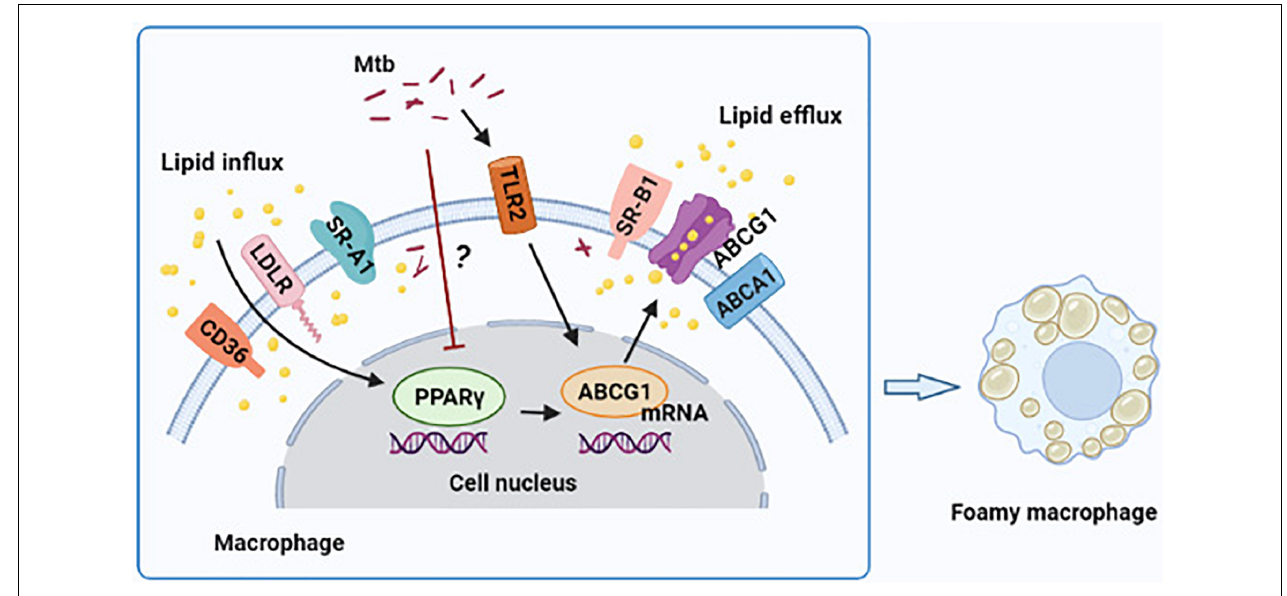
FIGURE 5 | Graphical summary depicting that peroxisome proliferator activated receptor γ (PPAR γ ) regulates Mtb H37Ra infection-induced foamy macrophage formation via the ABCG1-dependent cholesterol efflux pathway. H37Ra infection reduces PPAR γ expression in macrophage in a currently unknown way, which results in the decrease of ABCG1 expression and intracellular lipid efflux. TLR2 is involved in the regulation of PPAR γ and ABCG1 expression, and it have a greater role to regulate ABCG1 compared to PPAR γ , but it is not the central regulator of PPAR γ